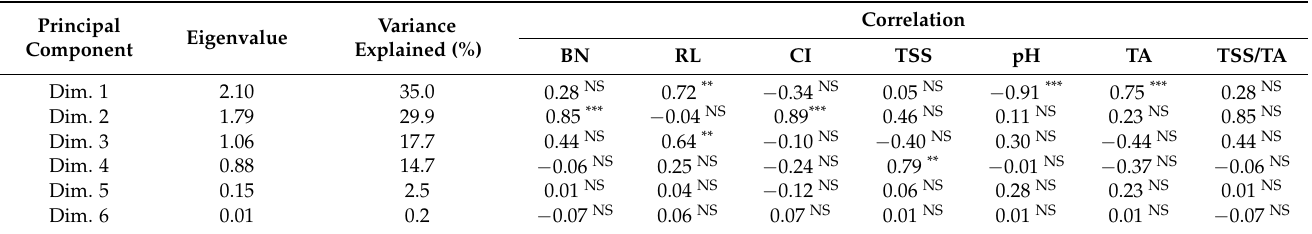
Table 3. Eigenvalue, percent of explained variance, and correlation with the eight original variables of the six principal components (Dim.) extracted. BN—number of berries per bunch; RL—Rachis